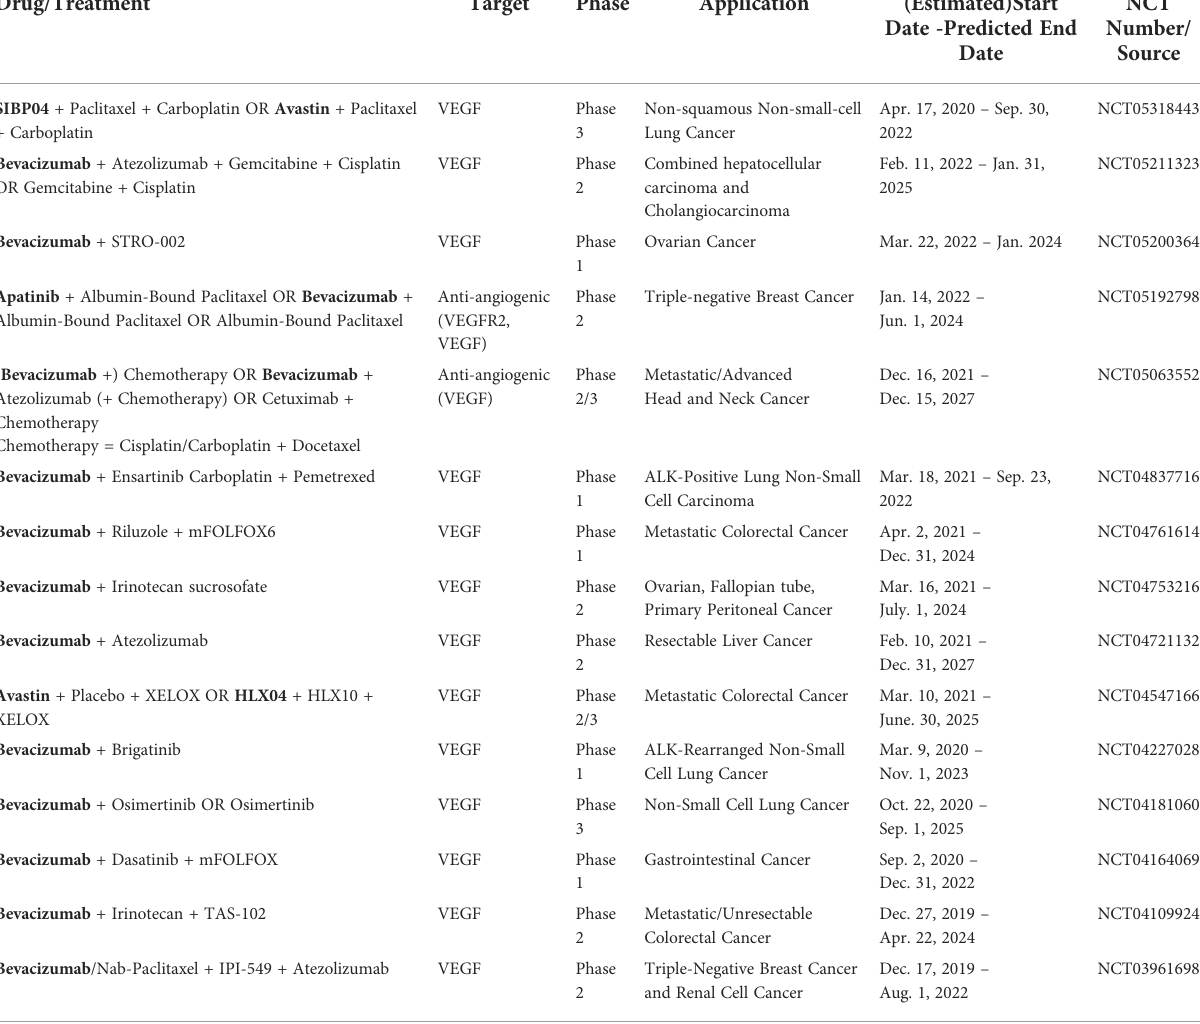
TABLE 1 Clinical Trials Targeting Cancers and Tumours using Anti-angiogenic Treatment.